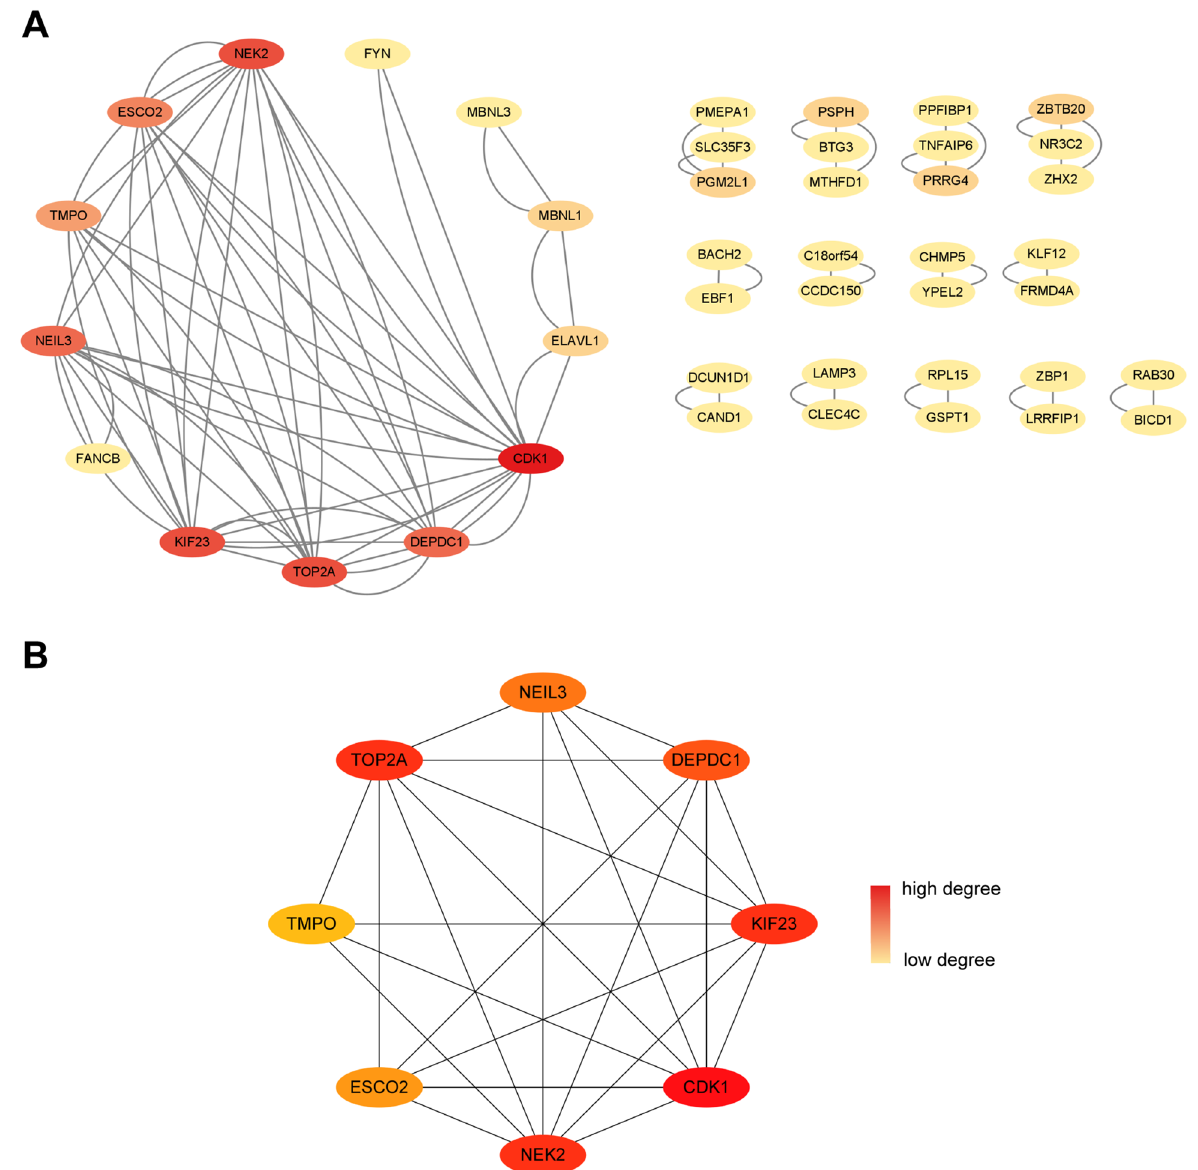
Figure 5. PPI network and gene module analysis. ( A ) PPI network diagram. ( B ) Significant gene module. The redder the color of the gene in the network, the higher the connectivity of the gene with other